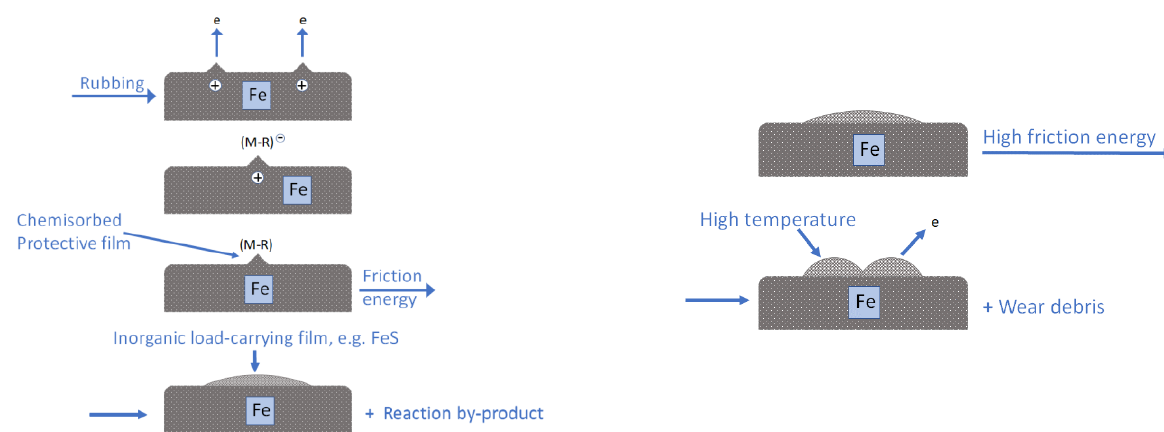
Figure 6. Process of ( left panel ) exoelectron emission (EEE) and of ( right panel ) destruction of the lubricant film and formation of activated surface spots.